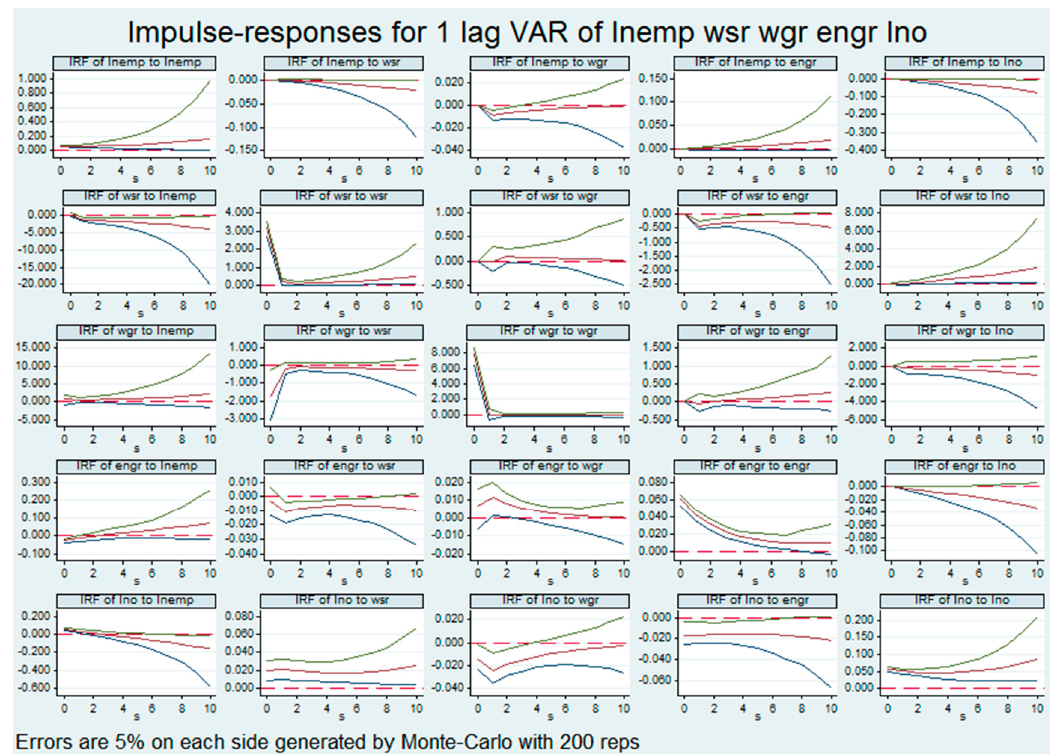
Figure 1. Clean industries impulse response function.